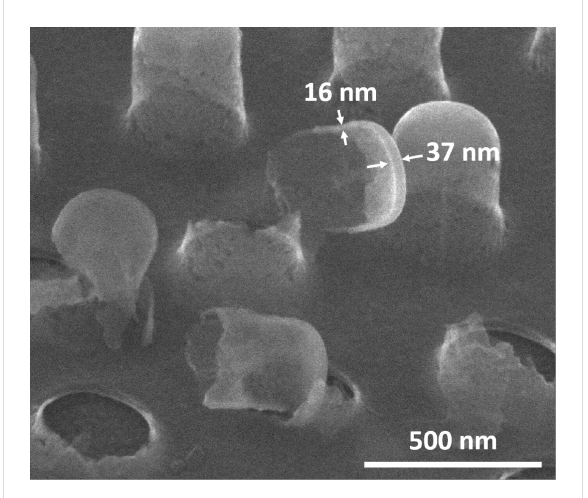
Figure 2: SEM image of hollow, closed, cylindrical nanocages made of thin-walled Al after an intentional scratch with a scalpel. Broken nano- cages allow the observation of the successful removal of the SU-8 nanopillars and the thickness of the cage sidewalls to be estimated. The nanocage top and sidewall Al film thicknesses are approximately 37 and 16 nm,